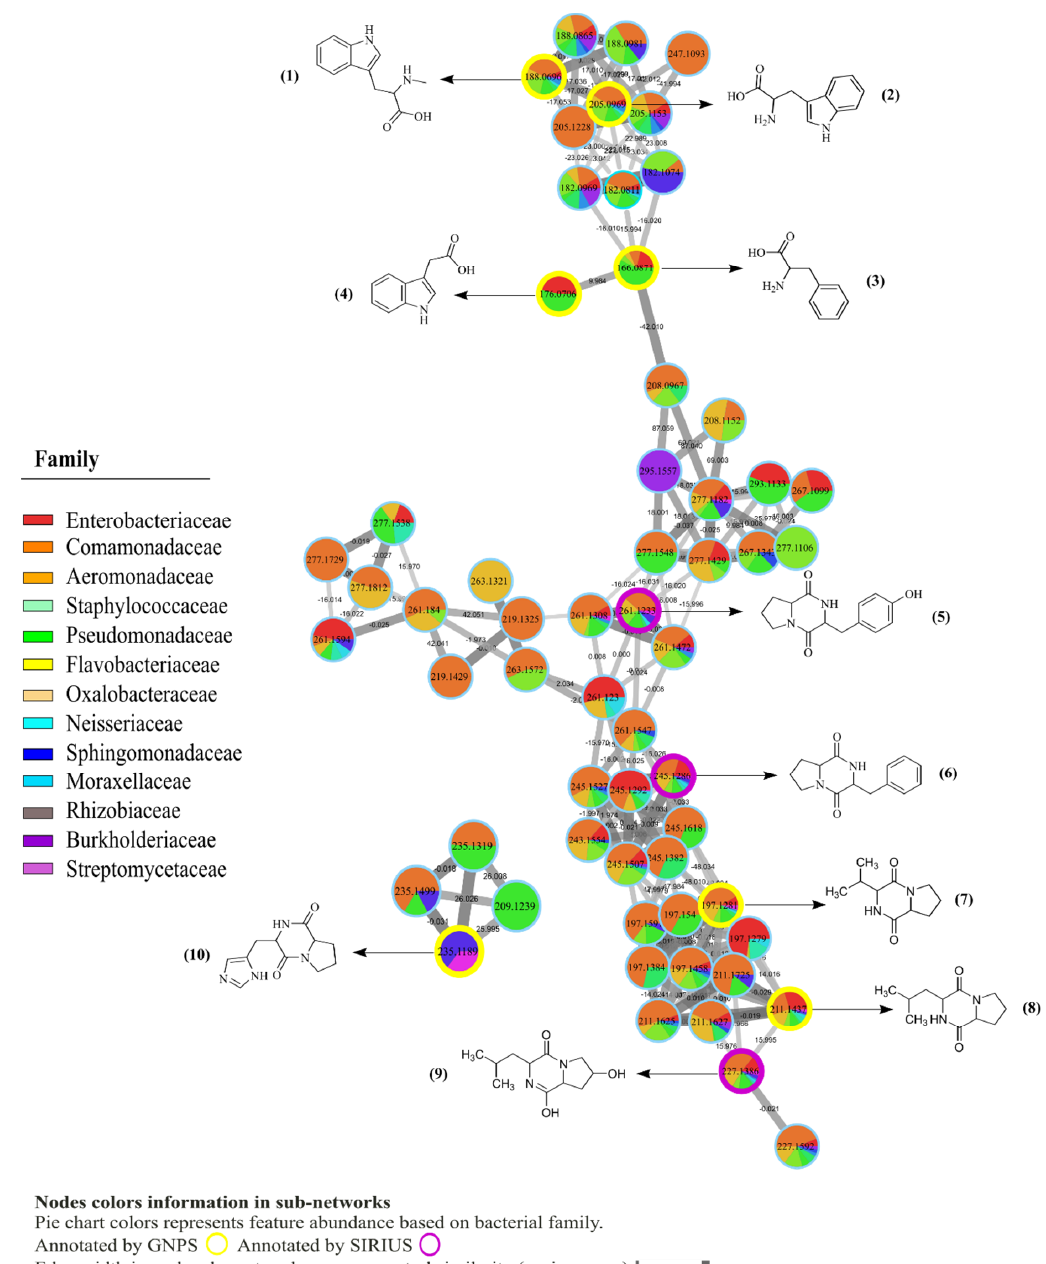
Figure 2. Molecular network of specialized metabolites (<300 Daltons) annotated in crude extracts of bacterial isolates from skin of C. panamansis by LC-MS/MS analysis. Highlighted nodes correspond to annotated metabolites by GNPS (yellow) and SIRIUS/CSIFingerID (purple). Pie charts inside nodes denotes abundance while colors correspond to the bacterial family where the feature was found. Edge width between nodes displays cosine score values, which are related to the spectral similarities between nodes.